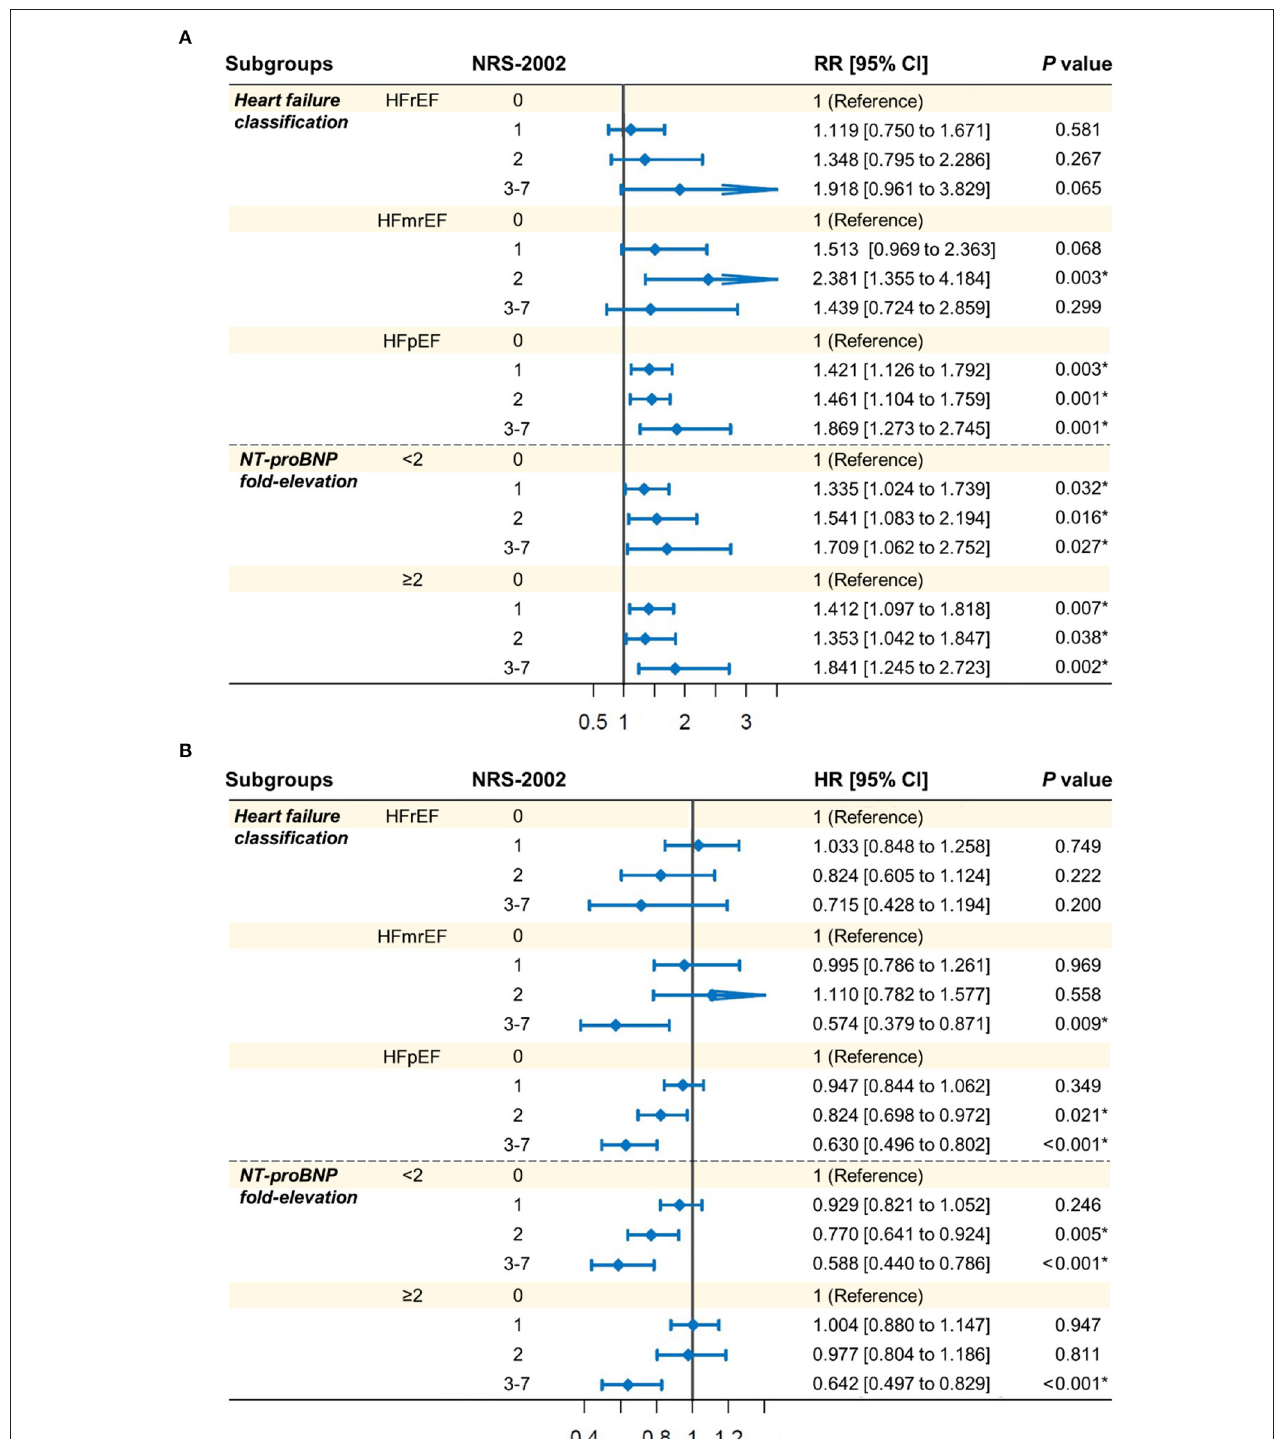
FIGURE 4 | Exploratory analysis in the association of NRS-2002 categories with (A) 1-year re-hospitalization and (B) the length of initial hospital stay. Patients were classified according to heart failure classification (HFrEF, EFmrEF, or HFpEF) and the level of NT-proBNP fold-elevation ( < 2 or ≥ 2). Log-binomial regression analysis (A) and Cox regression analysis (B) were performed for different endpoints with the same covariates as in adjusted model 2 in Table 2 , respectively. NRS-2002, Nutritional Risk Screening 2002; RR, relative risk; HR, hazard ratio; CI, confidence interval; HFrEF, heart failure with reduced ejection fraction; HFmrEF, heart failure with mid-range ejection fraction; HFpEF, heart failure with preserved ejection fraction; NT-proBNP, N-terminal pro-B-type natriuretic peptide.